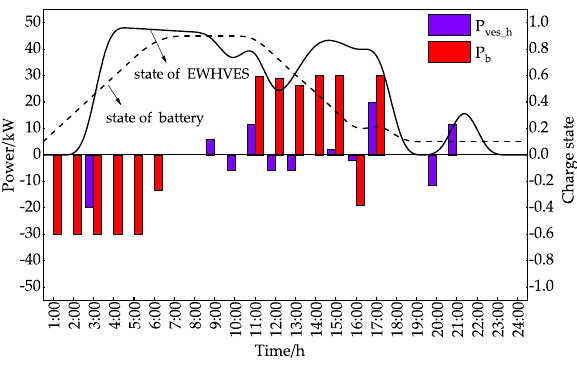
Figure 7. The EWHVES and battery charging/discharging power and their state of charge.